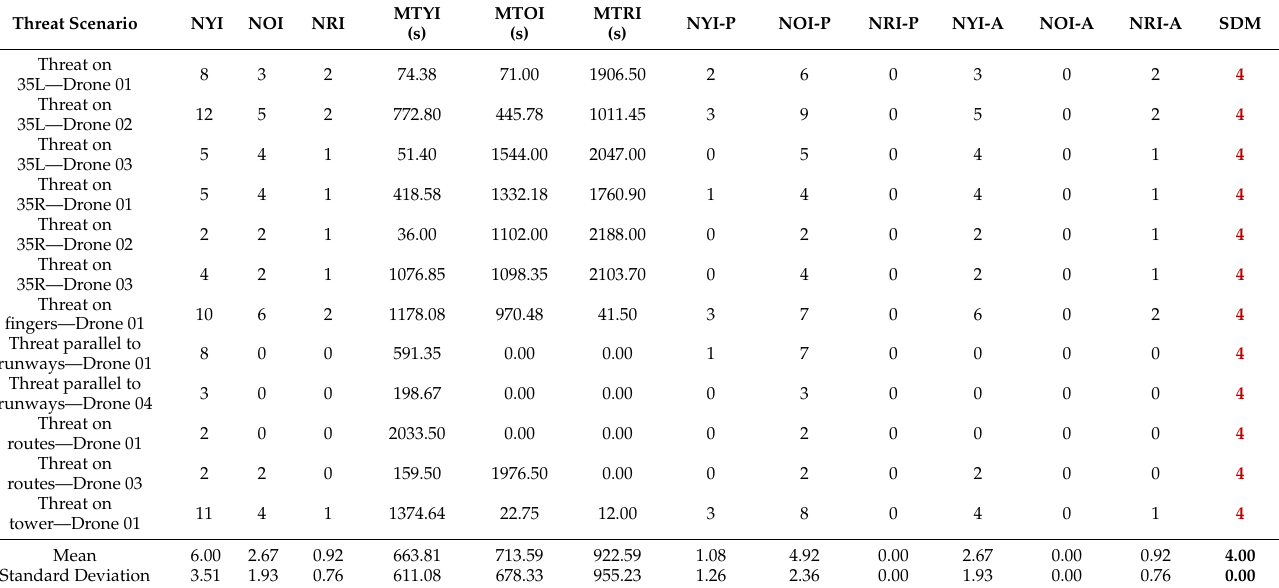
Table A1. Simulation results: safety metrics of reference scenarios. The following colors are used for SDM values: red for catastrophic (4) value; orange for hazardous (3) value; yellow for major (2) value; green for minor (1) value. Bold values respectively represent the mean and the standard deviation of SDM values.